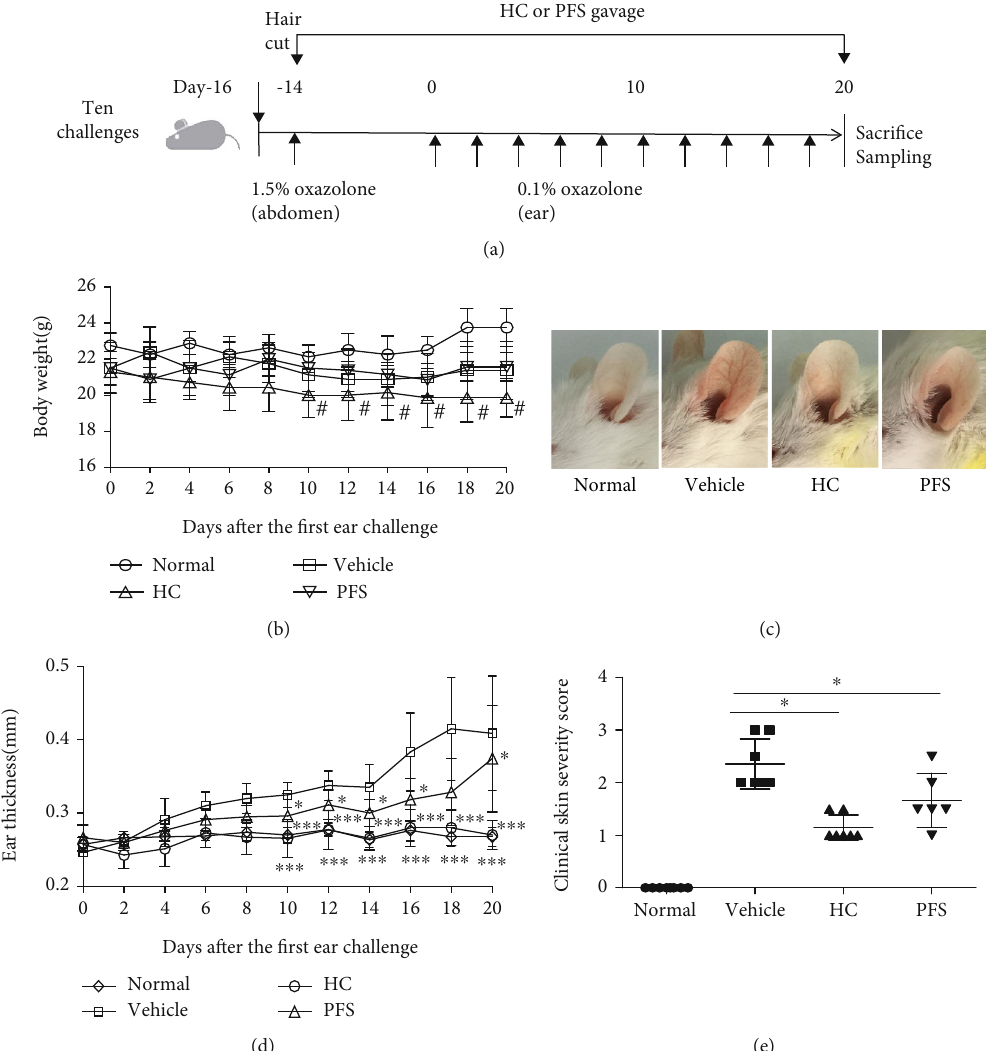
Figure 2: PFS improved the development of atopic dermatitis- (AD-) like symptoms in oxazolone-induced BALB/c mice (ten-time challenge). BALB/c female mice were sensitized as described in Materials and Methods. The PFS and HC groups were intragastrically administered with PFS or HC continuously for 34 days. (a) Experimental protocol; (b) clinical features of AD-like skin lesions at day 20; (c) thickness of the left ear of the mouse; (d) clinical score of AD-like skin lesions at day 20. Data are shown as mean ± SEM ( n = 6 -8), ∗ p < 0 : 05 , ∗∗ p < 0 : 01 , and ∗∗∗ p < 0 : 001 versus the vehicle group; # p < 0 : 05 versus the PFS